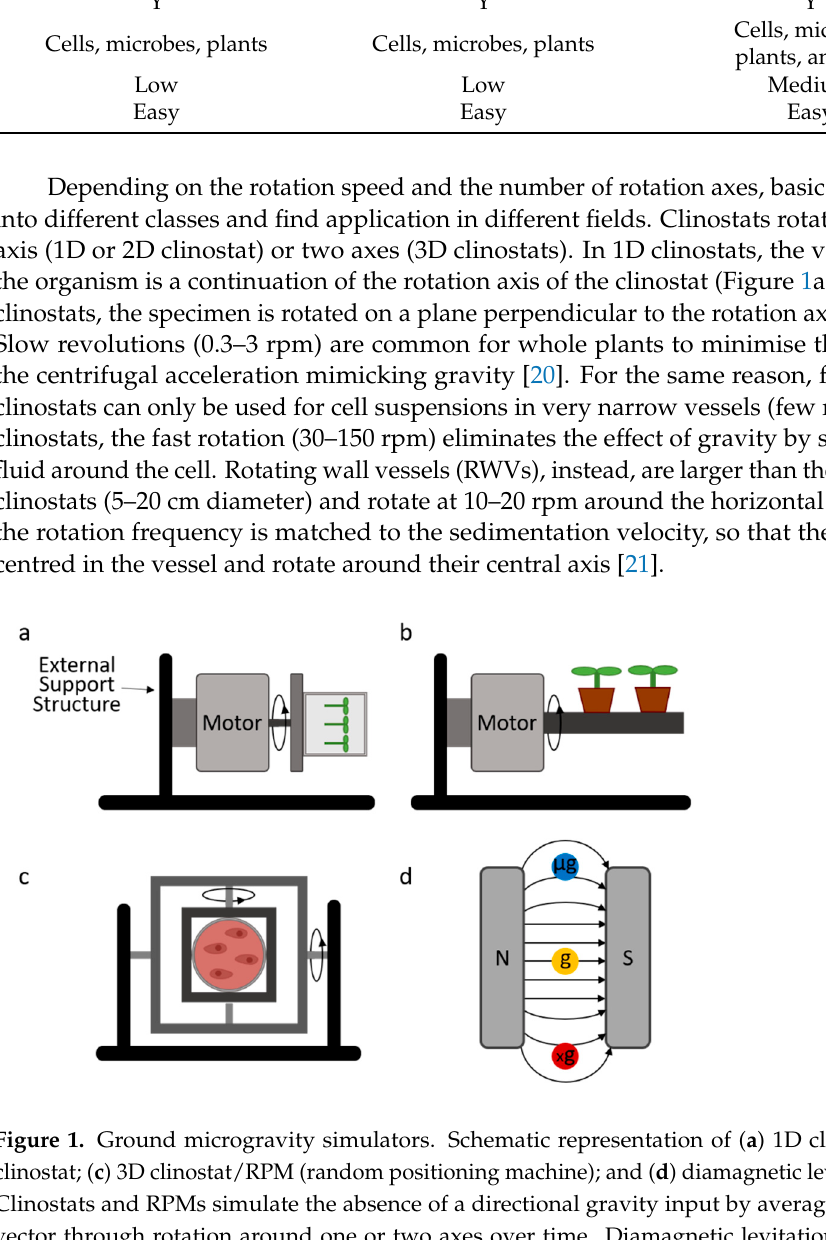
Table 1. Specifications of ground microgravity simulators. RWV, rotating wall vessel; RPM, random positioning machine.